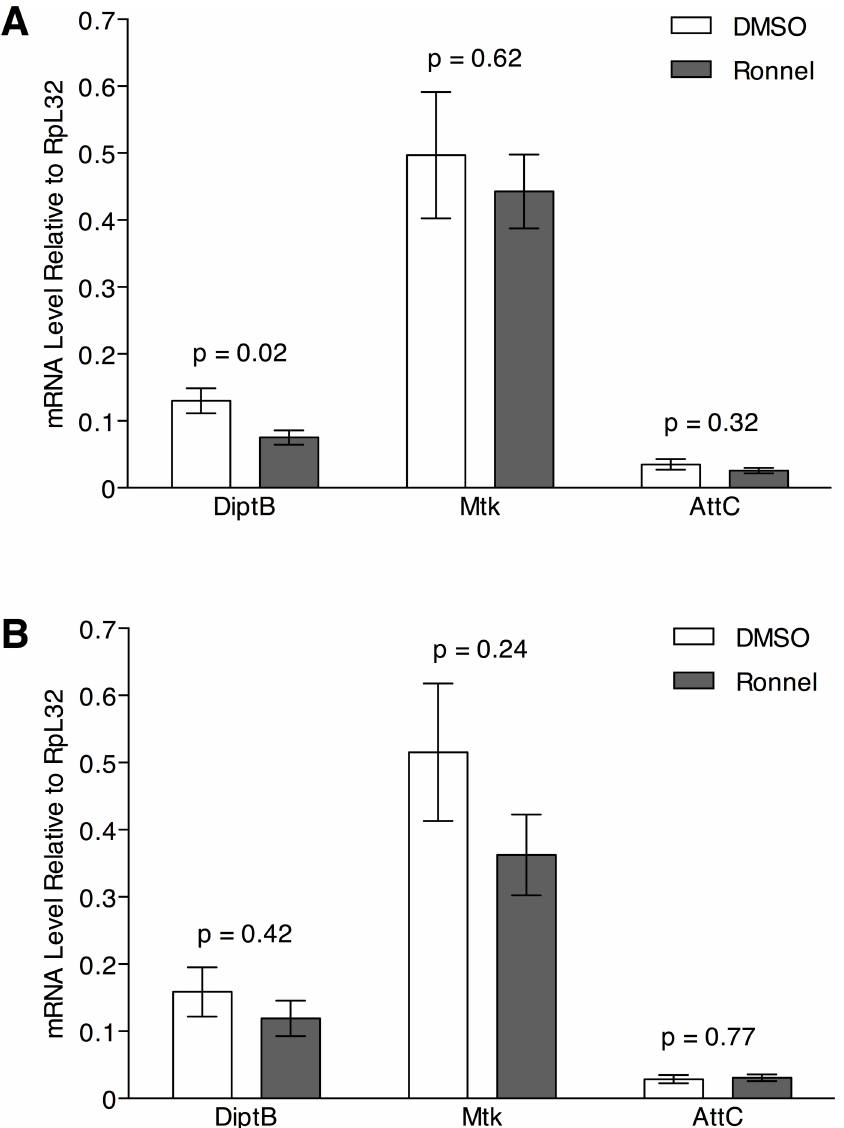
Fig 3. Ronnel does not affect the innate immune response of ATM 8 flies. The expressionof AMP genes ( DiptB , Mtk , and AttC ) was determinedby RT-qPCR in (A) ATM 8 flies raised on 0.2% DMSO (DMSO) or 0.02 mM Ronnelin 0.2% DMSO (Ronnel)at 21˚C and transferred to 25˚C for 24 hrs or (B) ATM 8 flies raised at 18˚C and transferred to 0.2% DMSO (DMSO) or 0.02 mM Ronnel in 0.2% DMSO (Ronnel)at 25˚C for 24 hrs. Data are presentedas the averageand standarderror of the mean for multipleindependentsamples. P- values were determined basedon an unpairedequal-variance two-tail t-test.